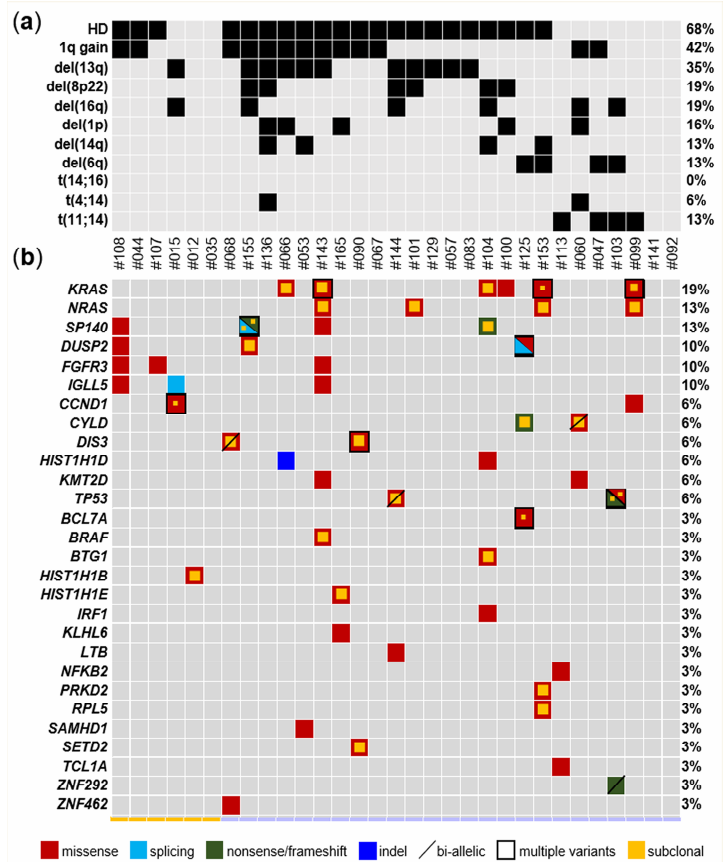
Figure 2. Overview of genomic aberrations and gene mutations in asymptomatic multiple myeloma. ( a ) Heatmap of selected chromosomal copy number alterations (CNAs), as assessed by ultra-low-pass whole genome sequencing (ULP-WGS), and immunoglobulin heavy chain locus (IGH) chromosomal translocations, as assessed by fluorescence in situ hybridization (FISH), in the six MGUS and 25 SMM patients. Only CNAs occurring in ≥4 samples are plotted; chromosome arms within which the CNAs (with variable extensions) localize are indicated. Gray squares indicate an absence of alterations, and black ones indicate their occurrence. ( b ) Mutated genes, color coded for missense (red), splice-site (light blue), nonsense / frameshift (green), indel (orange). A diagonal bar highlights mutations occurring in a gene with a copy number of 1. In the case of multiple variants detected, the squares are countered in black. A smaller internal yellow square denotes subclonal mutations. Only genes mutated in at least one sample are plotted. Each column represents one tumor sample and each row represents one chromosomal alteration / gene. MGUS samples are indicated in yellow, and SMM samples in lilac. The percentage of tumors carrying each alteration is provided on the